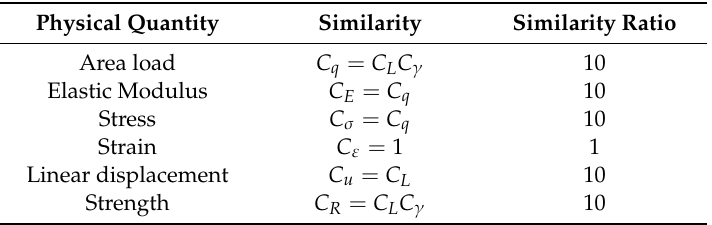
Table 4. Similarity Ratios of Key